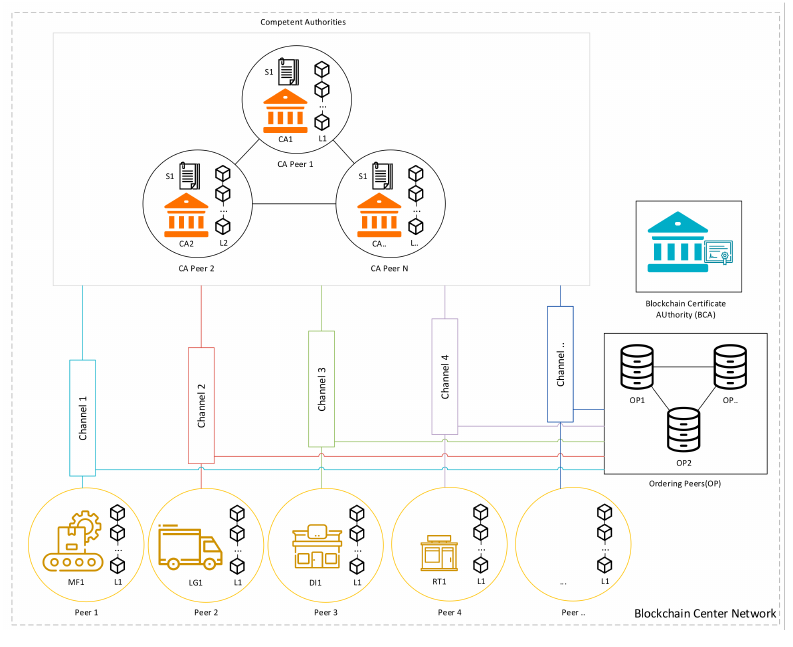
Figure 3. Blockchain center network architecture.